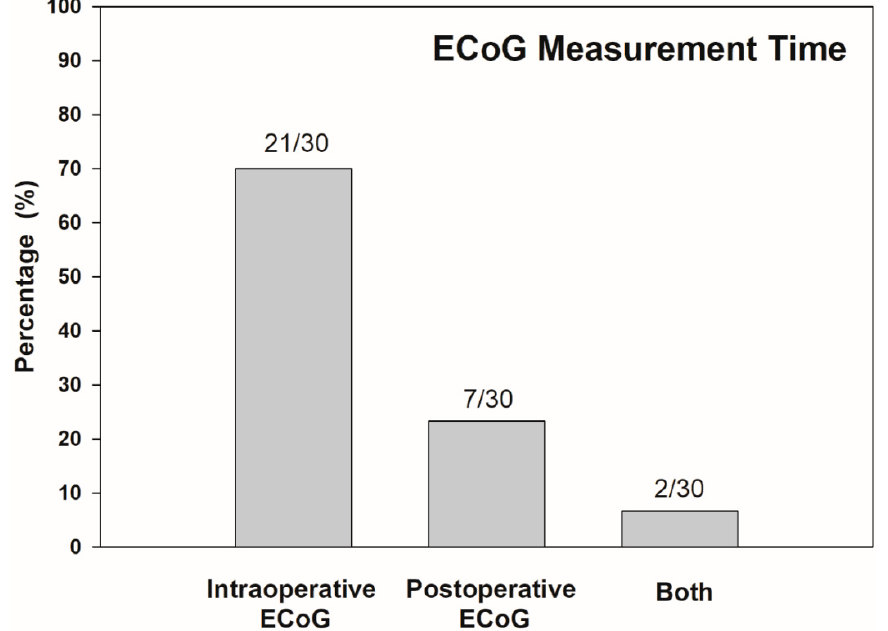
Figure 2. Distribution of time at ECoG measurement across all papers reviewed ( n = 30). Numbers above bars indicate number of studies corresponding each measurement